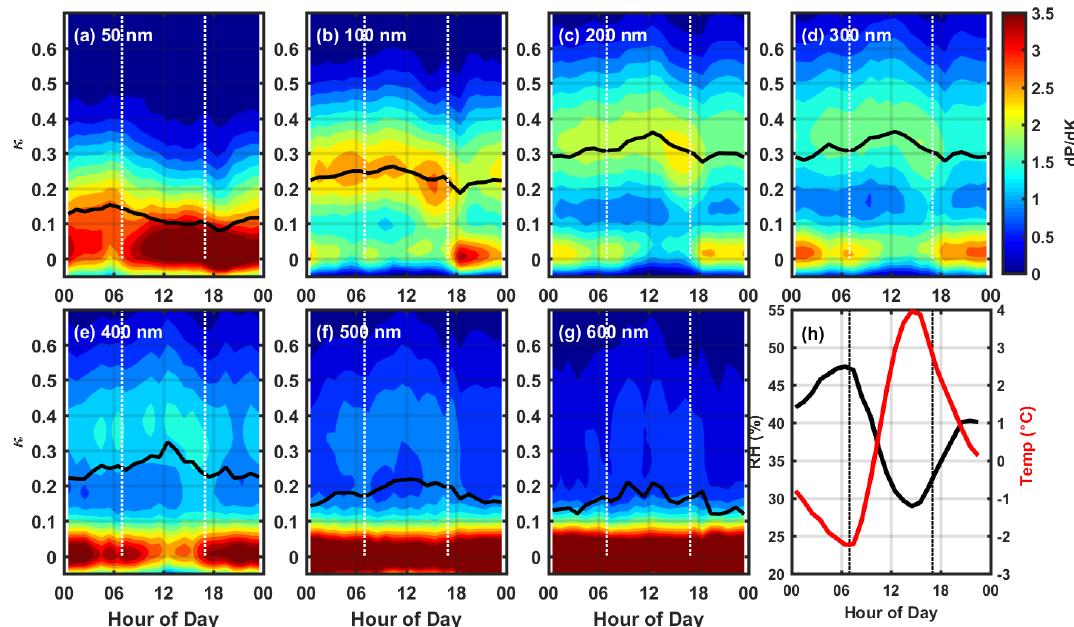
Figure 4. Diurnal variations in aerosol hygroscopicity distribution function over different sizes from 50–600nm. Panel (h) shows the mean diurnal temperature and relative humidity. The black lines in (a) – (g) are the mean hygroscopicity calculated from the average κ -PDF. The dotted vertical lines in all the figures denote the time of sunrise ( ∼ 07:00) and sunset ( ∼ 05:00). Table 3. Diurnal variations in aerosol hygroscopic properties for different